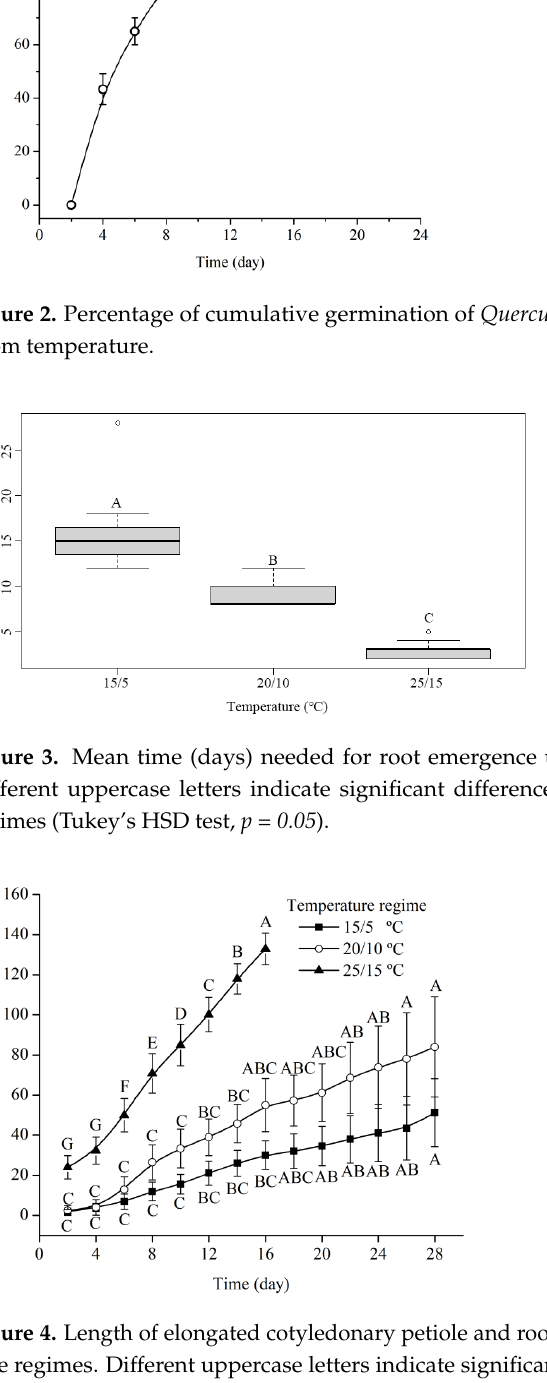
83.33 ± 5.77 A Note: Means with different uppercase letters indicate significant differences between the incuba- tion temperature regimes (Tukey’s HSD test, p = 0.05 ). Shoot emergence in seeds transferred from the 20/10 °C to the 30/20 °C regime nearly reached 30% after 1 month, and it was significantly higher than in seeds trans-